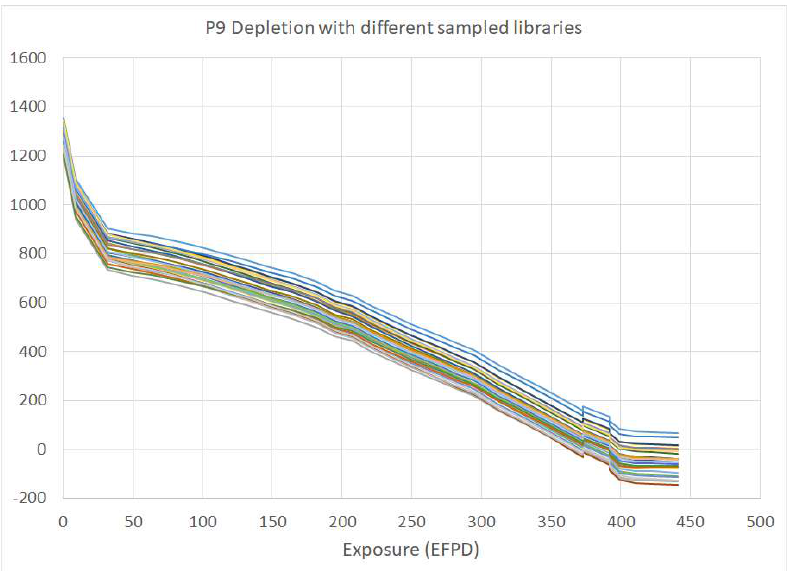
Figure 2. Full Core Depletion for Watts Bar Unit 1 Cycle 1 with Perturbed Cross Section